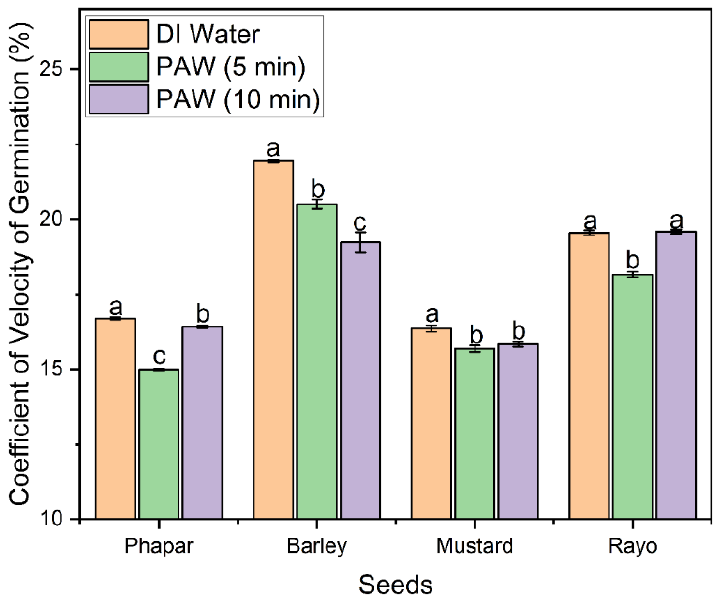
Figure 8. Effect of PAW on the coefficient of velocity of germination (CVG) of seeds. Different letters (a–c) indicate significant differences at p < 0.05 level among all treatments as determined by Tukey’s multiple comparison test.